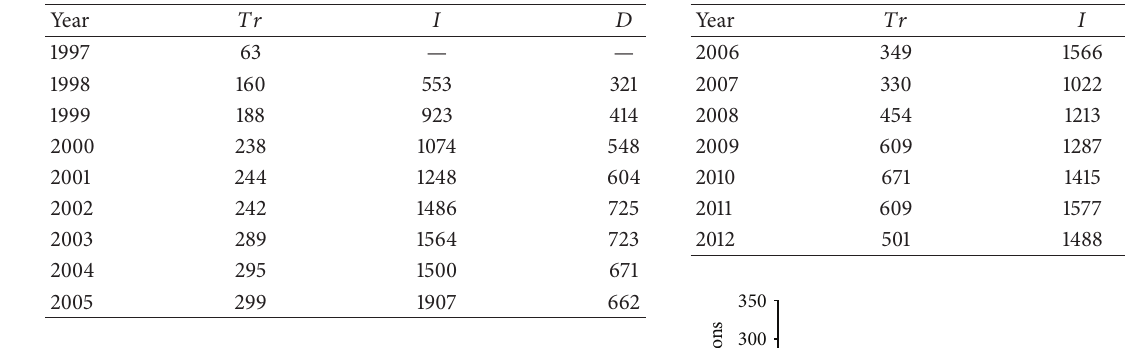
Table 1: Actual number of liver transplantations (1997–2005) ( 𝑇𝑟 ), the incidence of new patients on the list ( 𝐼 ), and the number of patients who died while being on the waiting list ( 𝐷 ), in the state of S˜ao Paulo from 1997 until 2005 (before MELD).